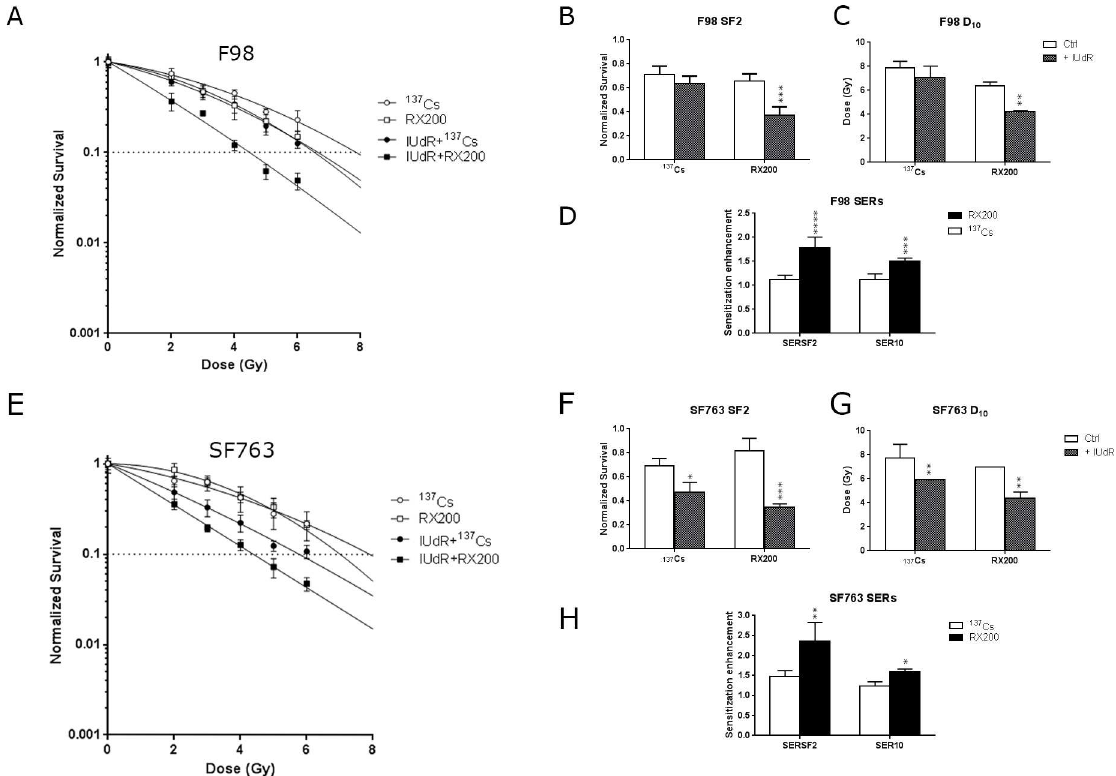
Fig 3. IUdR radiosensitization is greater with with low-energy X-rays compared to 137 Cesium photons. (A) Cell survival assays obtained with F98 cell line treated with or without IUdR before irradiationwith RX200(72.5 keV) or 137 Cs (662 keV) (n (cid:21) 3). Same experiments were performed with humanglioblastoma SF763 cells. The corresponding survival assays (D), (E) surviving fractions at 2Gy (SF2), (F) doses giving 10% of cell survival (D 10 ) and (G) sensitizationenhancement ratios (SER) (G) are presented(n (cid:21)